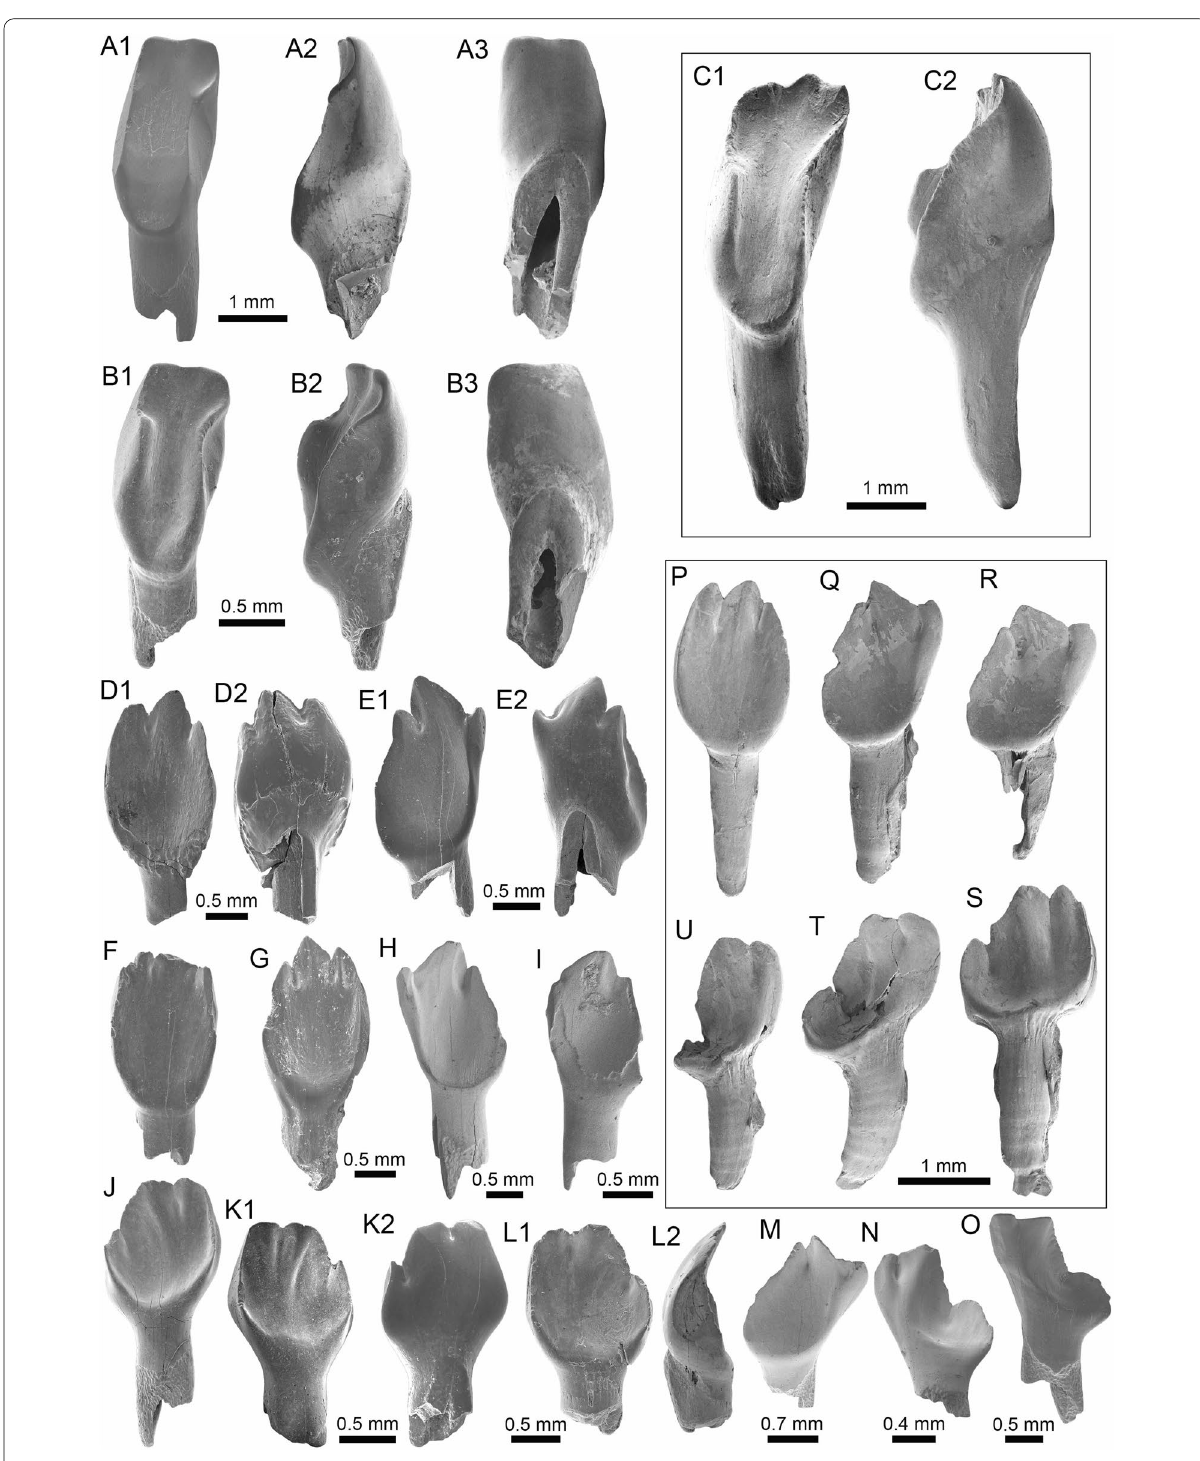
Fig. 5 Characiformes (Anostomidae) from the Vergel Member. A1 – B3 Premaxillary symphyseal teeth of cf. Megaleporinus sp. (AMU‑CURS‑851). C1 , C2 Recent premaxillary symphyseal tooth of Megaleporinus muyscorum (PIMUZ A/I 4856). D1 – O Schizodon cf. S . corti teeth ( D1 – G , J – L AMU‑CURS‑849, and H , I , M – O AMU‑CURS‑849), of both premaxillary ( D1 – I ) and dentary position ( J – O ). P – U Recent teeth of Schizodon corti (PIMUZ A/I 4869) [premaxillary ( P – R ) and dentary teeth ( S – U ), symphyseal teeth ( P and S )]. Views: labial ( A3 , B3 , D2 , E2 , K2 ), lingual ( A1 , B1 , C1 , D1 , E1 , F-K1 , L1 , M-U ), and lateral ( A2 , B2 , C2 , L2